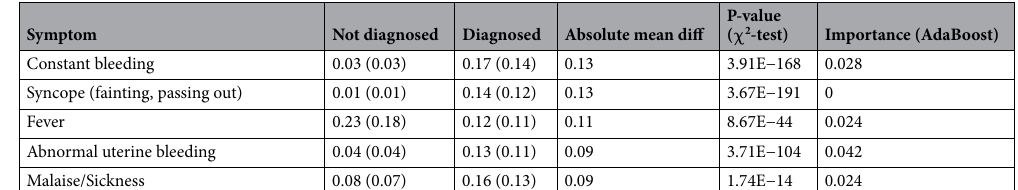
Table 1. Descriptive statistics that indicate the importance of each symptom. For each symptom we present the percentage (mean and variance in parenthesis) of undiagnosed and diagnosed women who experience the symptom, the absolute mean (frequency) difference between undiagnosed and diagnosed women, and whether the difference is significant (chi-square test, p-value < 0.01). The rightmost column presents the importance of each symptom according to the AdaBoost model, which is detailed below.